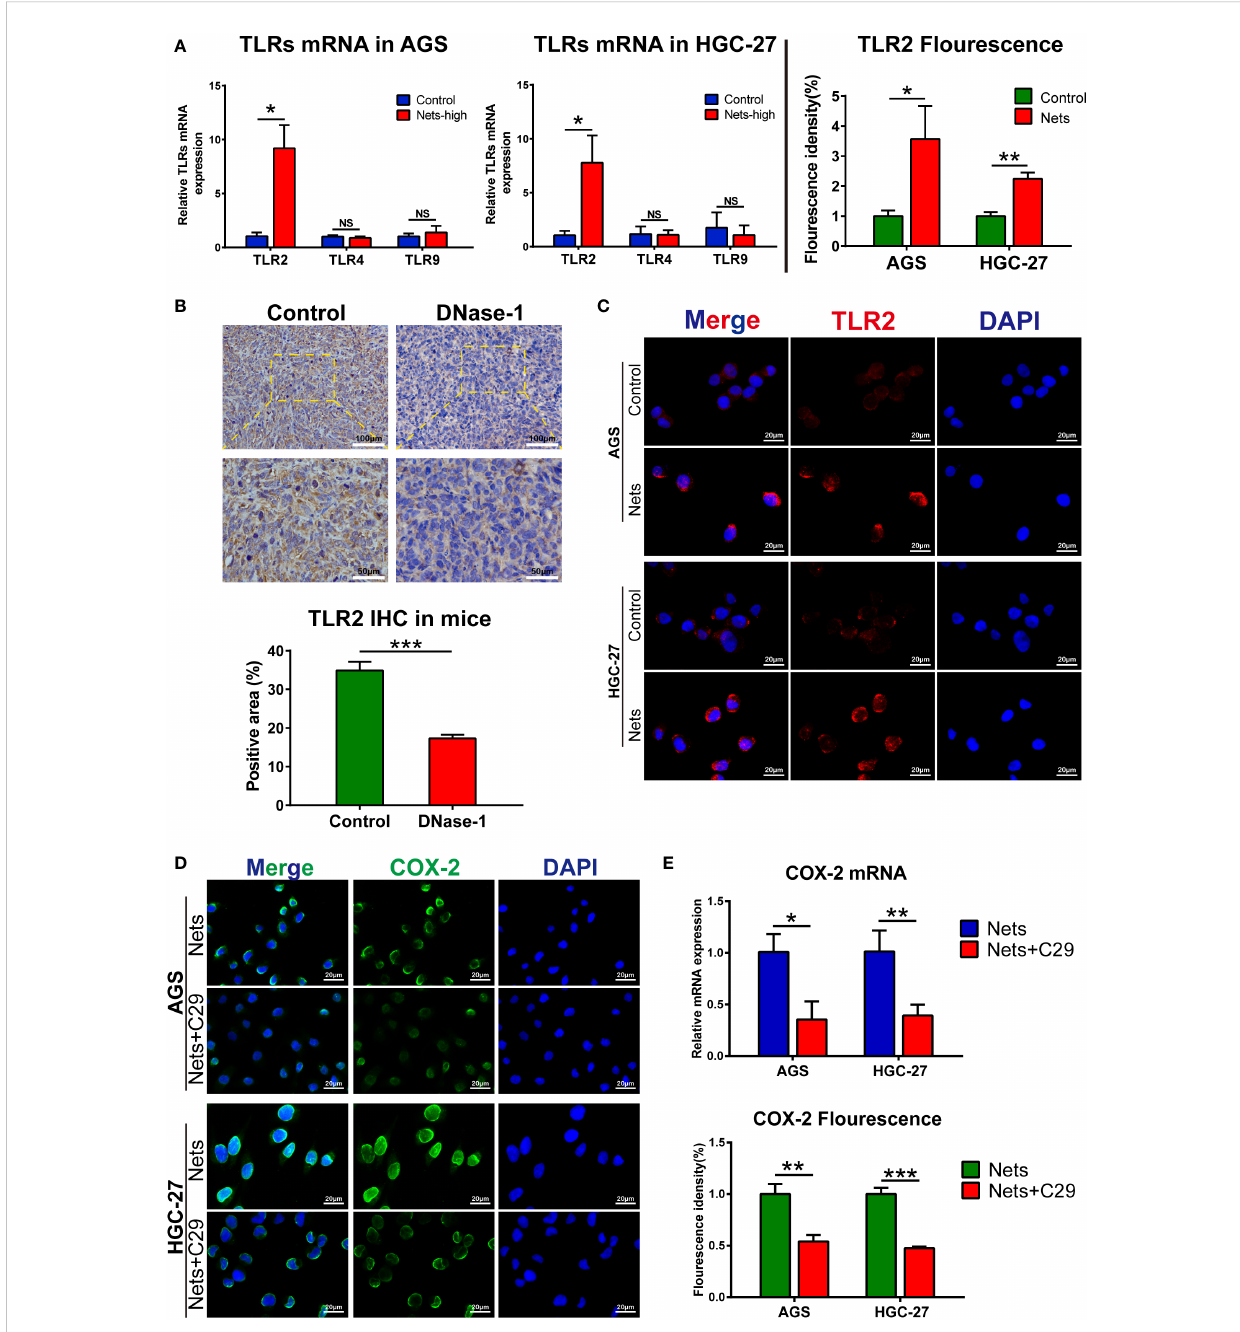
FIGURE 5 TLR2 is the pivot for NETs to regulate COX-2 (A) The mRNA expression of TLRs in two gastric cancer cell lines after NETs stimulation. (*p<0.05 vs. Control; NS, no signi fi cance; n=3) (B) The expression of TLR2 in subcutaneous tumors was decreased after the nude mice were intraperitoneal injected Dnase-1. (***p<0.001 vs. Control; n=3) (C) Representative images of TLR2 distribution and expression in two gastric cancer cell lines after NETs stimulation. The expression of TLR2 was evaluated by statistical fl uorescence intensity. (*p<0.05; **p<0.01; n=3) (D) TLR2 inhibitor C29 affects the expression of COX-2 in gastric cancer cells stimulated by NETs, the distribution and expression of COX-2 are illustrated in the fi gure. The expression of target gene was evaluated by its fl uorescence intensity. (**p<0.01; ***p<0.001; n=3) (E) TLR2 inhibitor (C29) affects the mRNA expression of COX-2 in gastric cancer cells stimulated by NETs, which were measured by real-time PCR. (*p<0.05; **p<0.01; n=3). All results are presented as mean ±